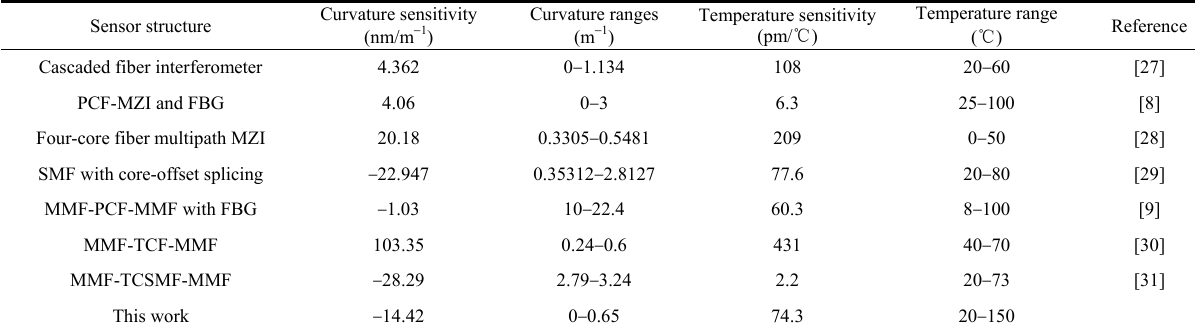
Table 1 Comparison between the proposed sensor and other